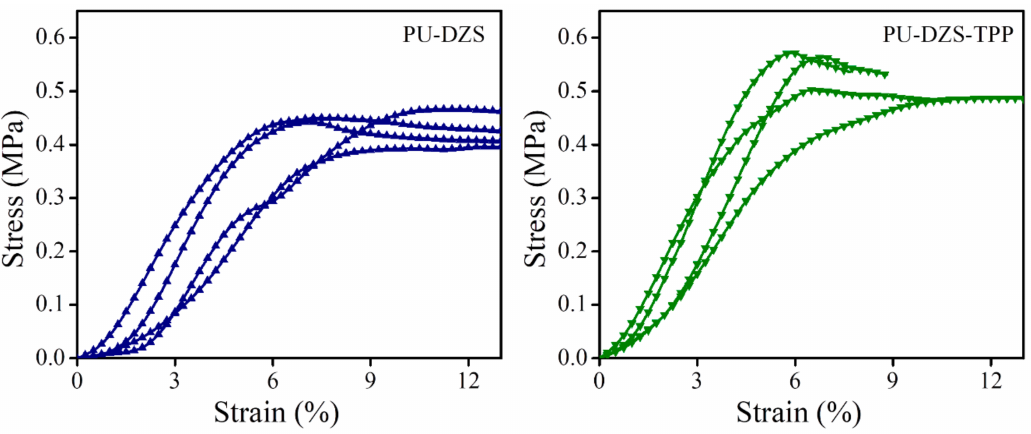
Figure 6. Compression stress-strain curves of PU-DZS ( left ) and PU-DZS-TPP 25 ( right )